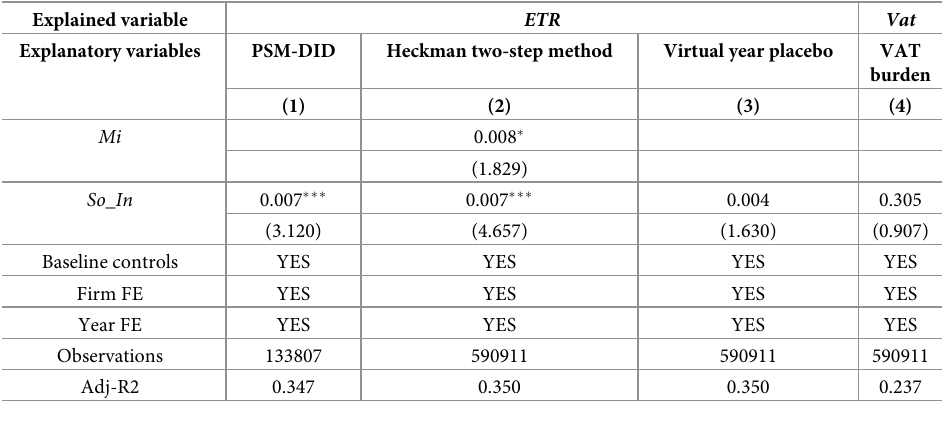
Table 5. Robustness Test